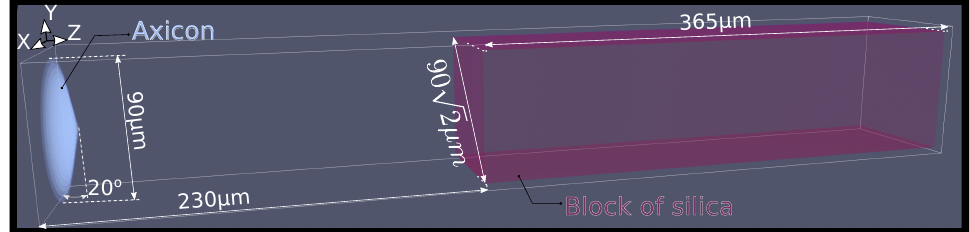
Figure 4. Computational domain.